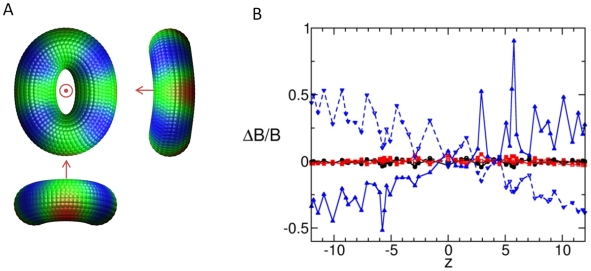
Differences in the mobilities of toroid models induced by mass redistribution.(A) Three views are shown for the second mode of a toroid with axially varying mass density. In each view, the z-axis is shown (by the dot or arrow). The uneven mass distribution causes increased mobility on the lighter side of the toroid (compare to Figure 2B). (B) The fraction change in mobility, ΔB/B, from the uniform-density toroid is plotted against axial coordinate for three toroid models with non-uniform mass distributions: mass distributions linearly dependent on radial coordinate (red squares), distance from minor axis (black circles), and axial coordinate (blue triangles). The solid lines and filled symbols refer to the first mode, which is only slightly altered in the first two cases, as indicated by all points falling close to zero on the ordinate. When the mass is distributed such that the cytoplasmic (z>0) side is more massive than the nuclear (z<0) side, there is an increase in mobility in the cytoplasmic side and a decrease in mobility in the nuclear side relative to the first mode. The opposite effect is observed for the second mode, shown in dashed lines.